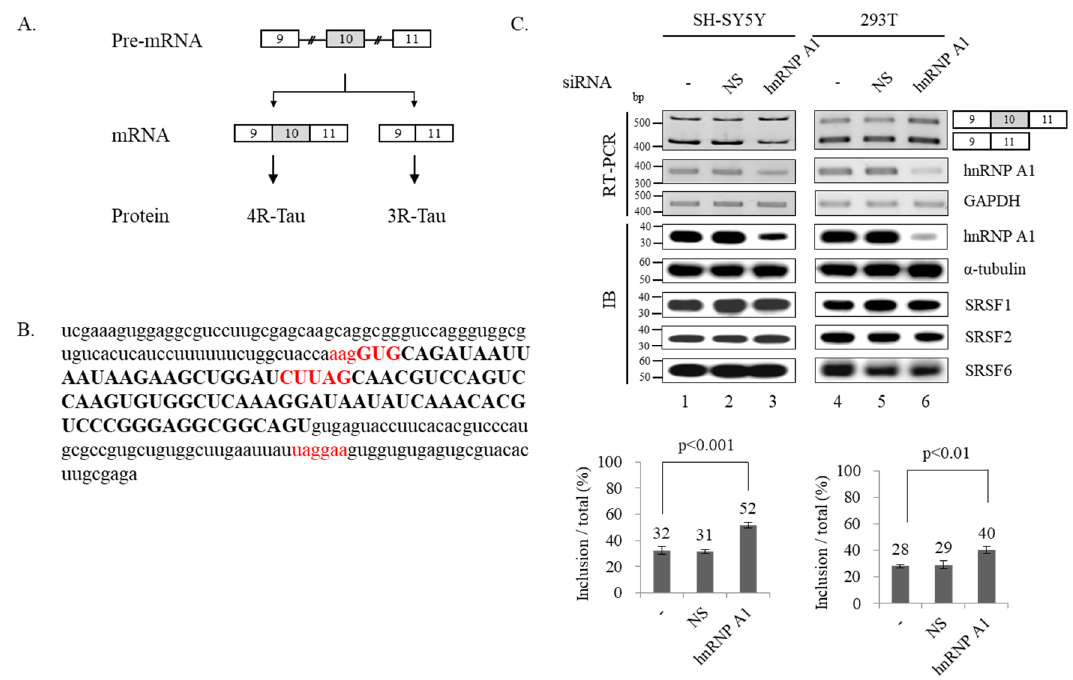
Figure 1. Reduced expression of hnRNP A1 results in increased alternative exon 10 inclusion of Tau pre-mRNA. ( A ) Schematic of Tau pre-mRNA splicing showing two mRNA isoforms produced by alternative splicing of Tau pre-mRNA. ( B ) RNA sequences of exon 10 and its surrounding 80 nt introns are shown. Exon is shown with upper case, introns are shown with lower case. Three potential hnRNP A1 binding sequences are highlighted with red. ( C ) (Upper) RT-PCR analysis of Tau exon 10 splicing in hnRNP A1 knockdown, untreated or non-silencing shRNA treated SH-SY5Y and 293T cells are shown. GAPDH is monitored as a loading control. Immunoblotting of hnRNP A1, α -tubulin, SRSF1, SRSF2 and SRSF6 are shown. (Lower) Bar charts of the exon 10 splicing are shown. P -values are shown.